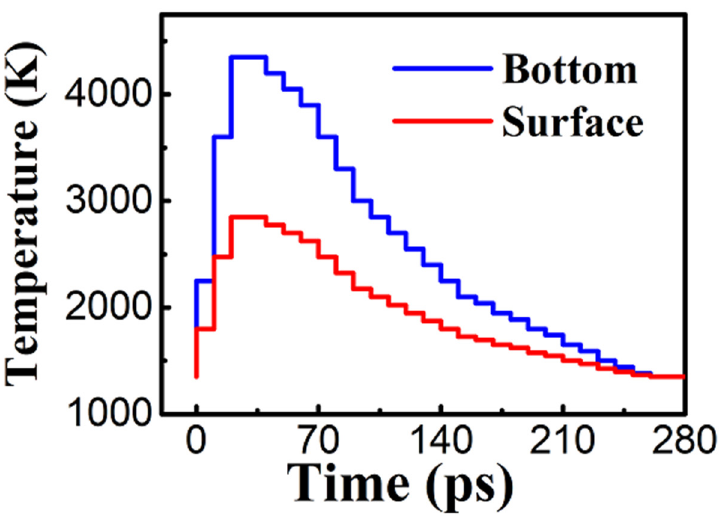
Figure 2. The temperature of the surface layers (red line) and bottom layers (blue line) as a function of time in the laser thermal annealing mode. The whole annealing time is 280 ps and is divided into 28 parts, i.e., 10 ps per part. The maximum temperature rise is set to 3000 K at surface layers. The maximum temperature at the bottom layers is 4500 K.